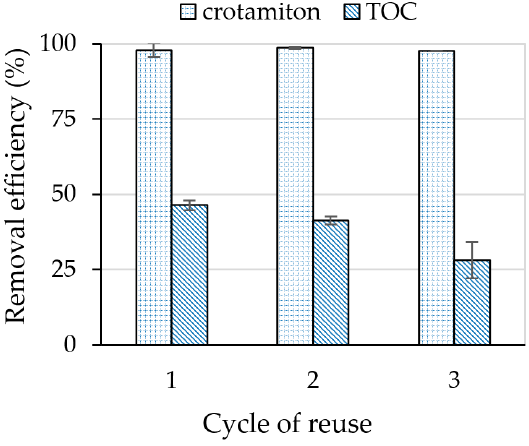
Figure 10. The removal efficiency of crotamiton and TOC in RO concentrate using the HSZ-385/P25 composite sheet after cyclic use. Results are means ± standard deviations ( n = 2).